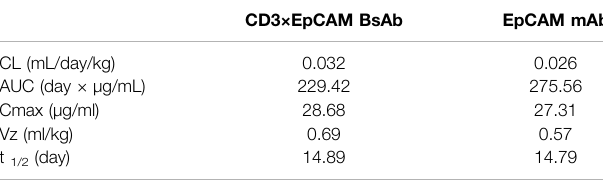
TABLE 3 | PK parameters of CD3×EpCAM BsAb and EpCAM